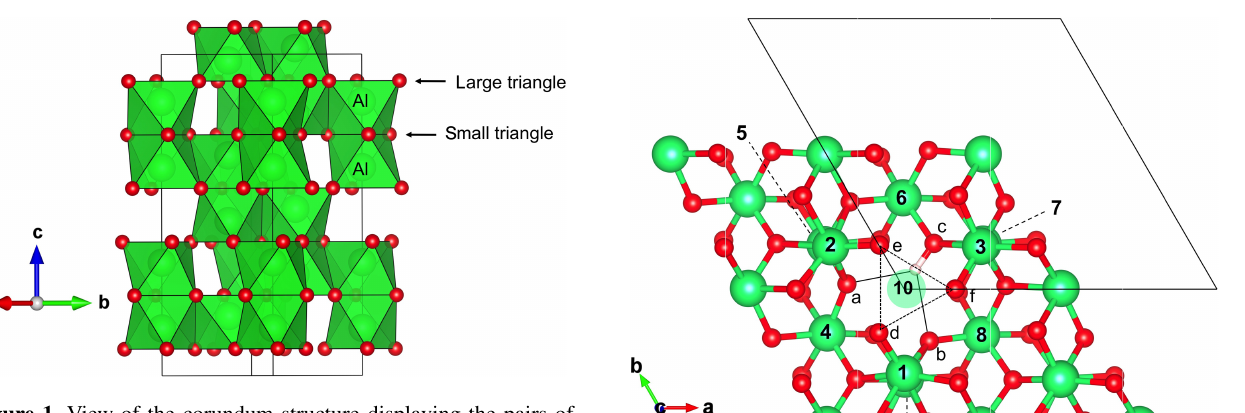
Figure 1. View of the corundum structure displaying the pairs of face-sharing octahedral sites. The shared face corresponds to the small oxygen triangle while the opposite face corresponds to the large triangle.